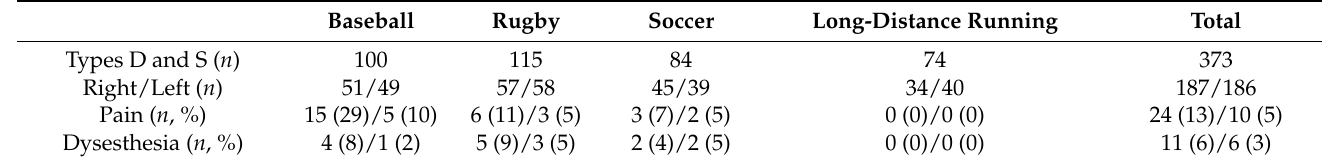
Table 4. Frequency of subjective symptoms among elbows with Types D and